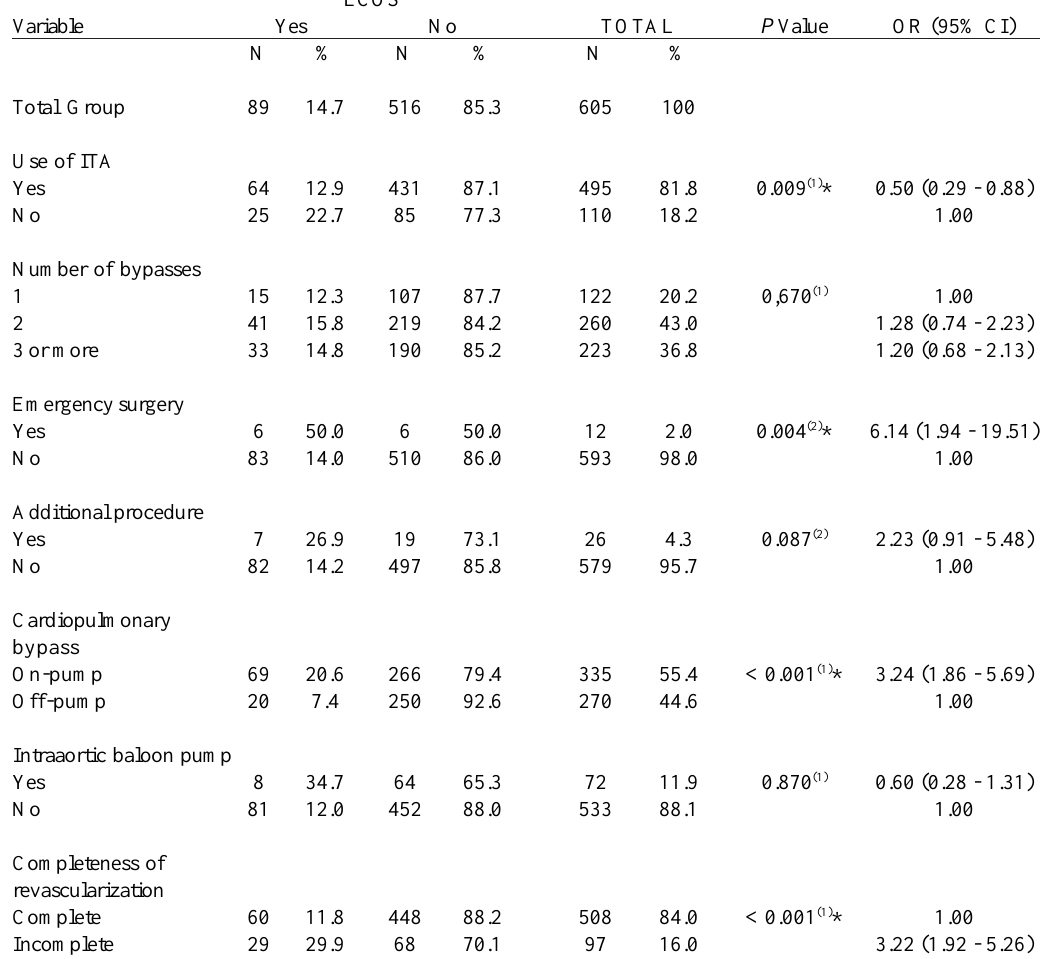
Table 2. Incidence of LCOS according to intraoperative